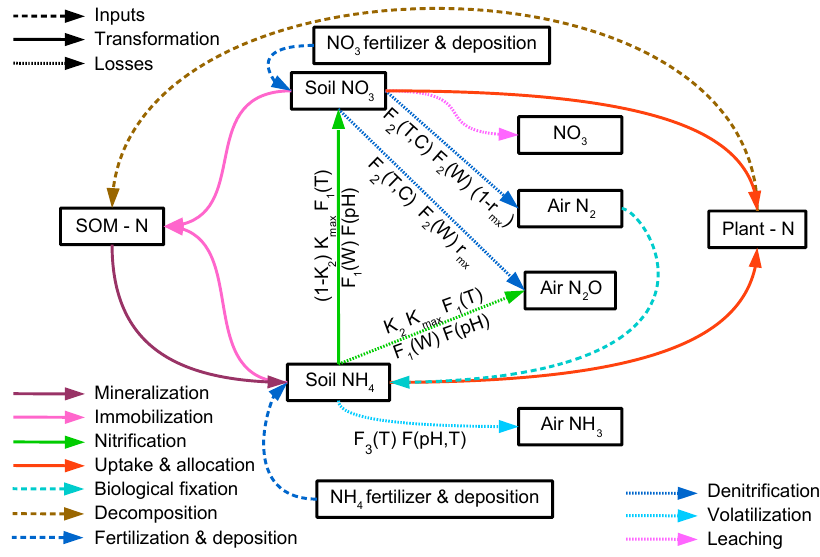
Figure 3. Nitrogen transformations and losses in soils. Pools and fluxes are denoted by boxes and arrows,